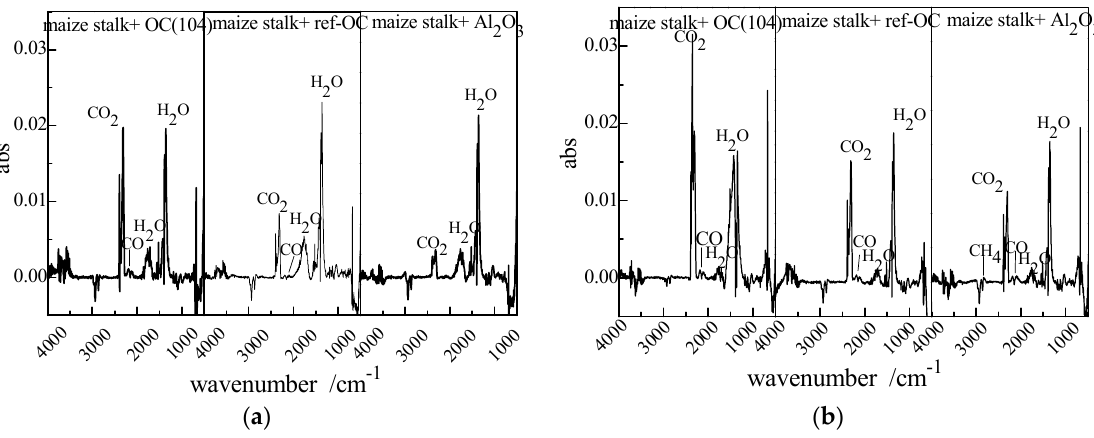
Figure 3. IR spectra for thermogravimetric experiment gas products of different samples. ( a ) time corresponding to the second characteristic peaks of TG curves; ( b ) time corresponding to the third characteristic peaks of TG curves.